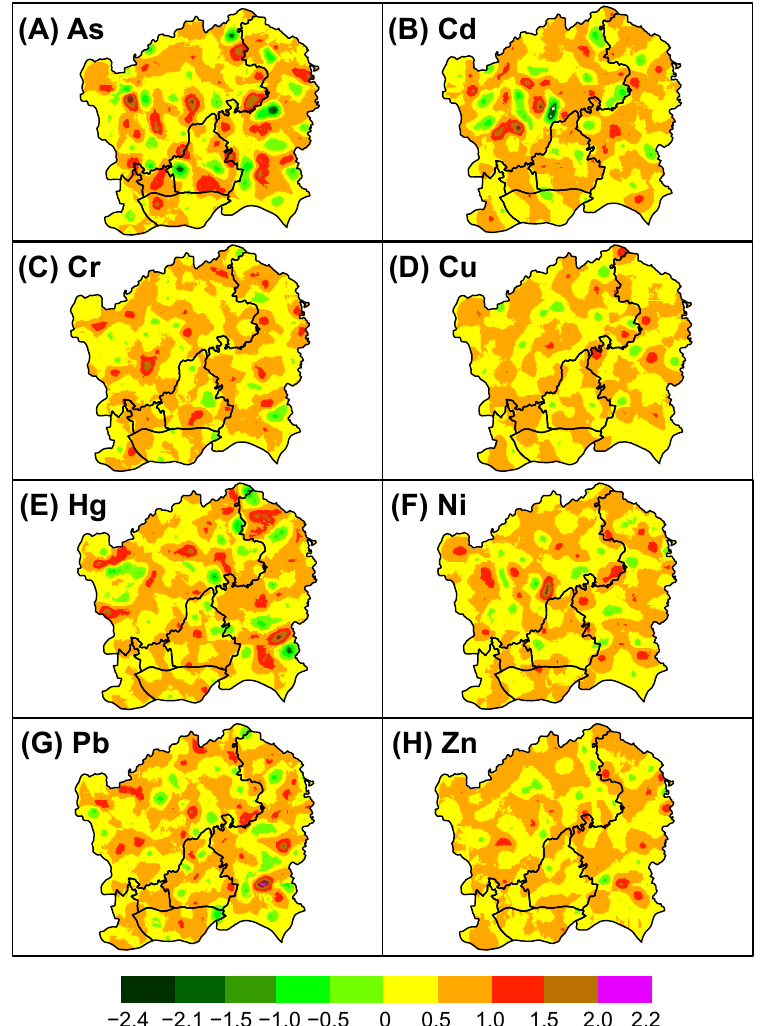
Figure 5. The cokriging maps of the spatial components for eight heavy metals at the long-range scale.